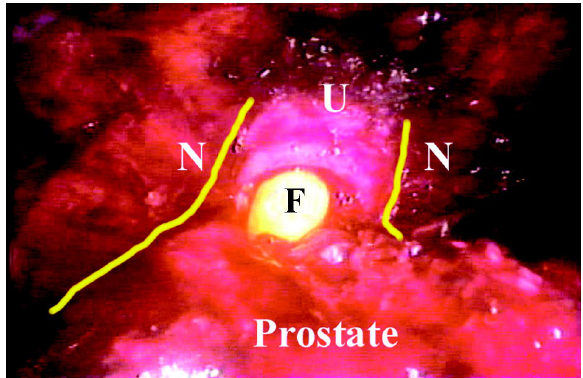
Figure 6 – Opening of the urethral anterior wall. Observe the Foley catheter (F) and the prostate apex, clearly identified. The path of the nervi erigentes (N), schematically identified with yel- low lines, is located laterally to the sectioning area in the ure- thra (U).